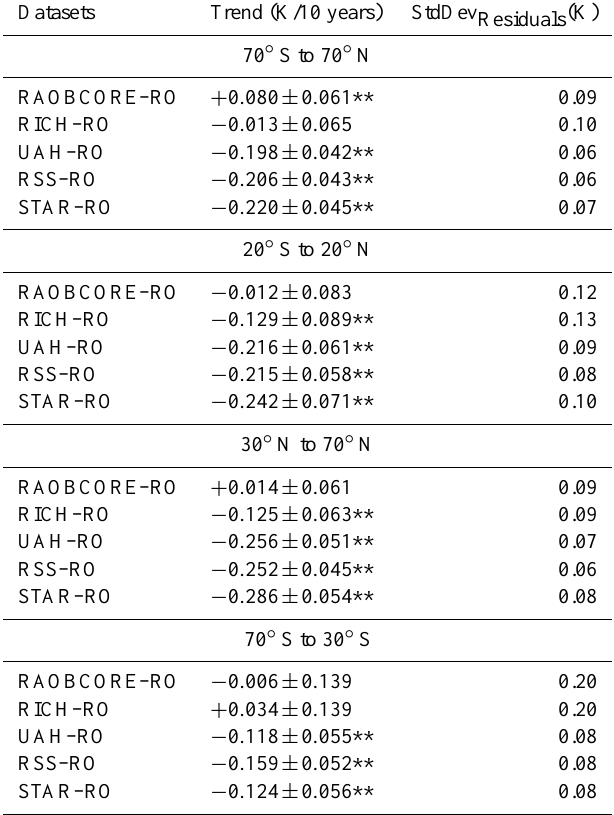
Temporal sampling of radiosondes (00:00 UTC and 12:00 UTC) seems to basically capture the diurnal variation up to the semi-diurnal cycle. This was investigated by using only 00:00 UTC and 12:00 UTC time layers of the reference field for calculating the sampling error, instead of the “full” field of four time layers. Comparing the sampling error based on 00:00 UTC and 12:00 UTC time layers with that based on the “full” field showed very small differences